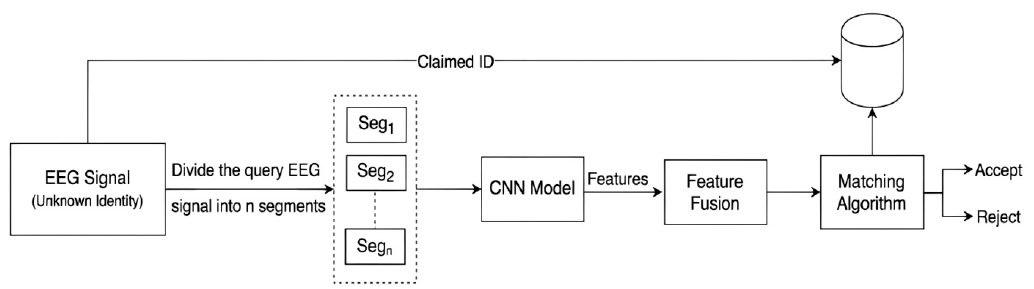
Figure 3. Authentication System.